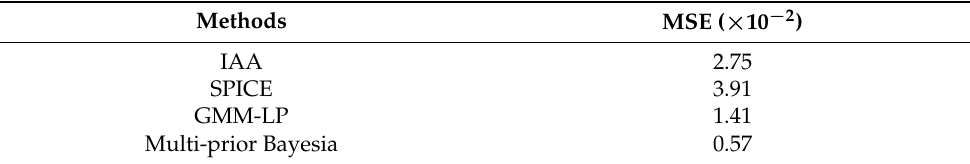
Table 3. MSE results at range cell 2745 m.